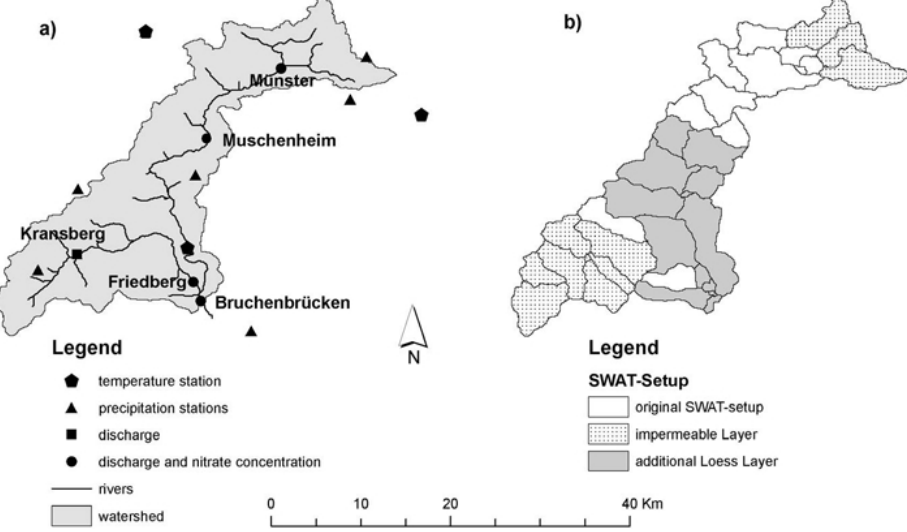
Fig. 2. Location of gauging stations (a) and model setup for model structure SWAT II (b) . In addition to the general model set up of SWAT I, impermeable soil layers in the low mountain region as well as additional deep soil layers in the centre of the watershed have been added in SWAT